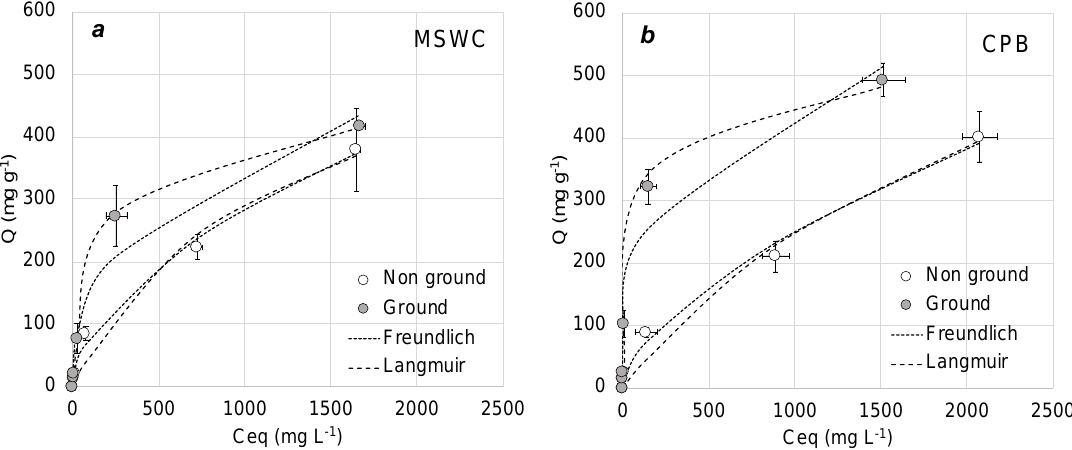
Figure 3. Adsorption curves at different particle size for ( a ) municipal solid waste compost (MSWC) and ( b ) composted pine bark (CPB). Bars show standard deviation of the mean (n = 3).